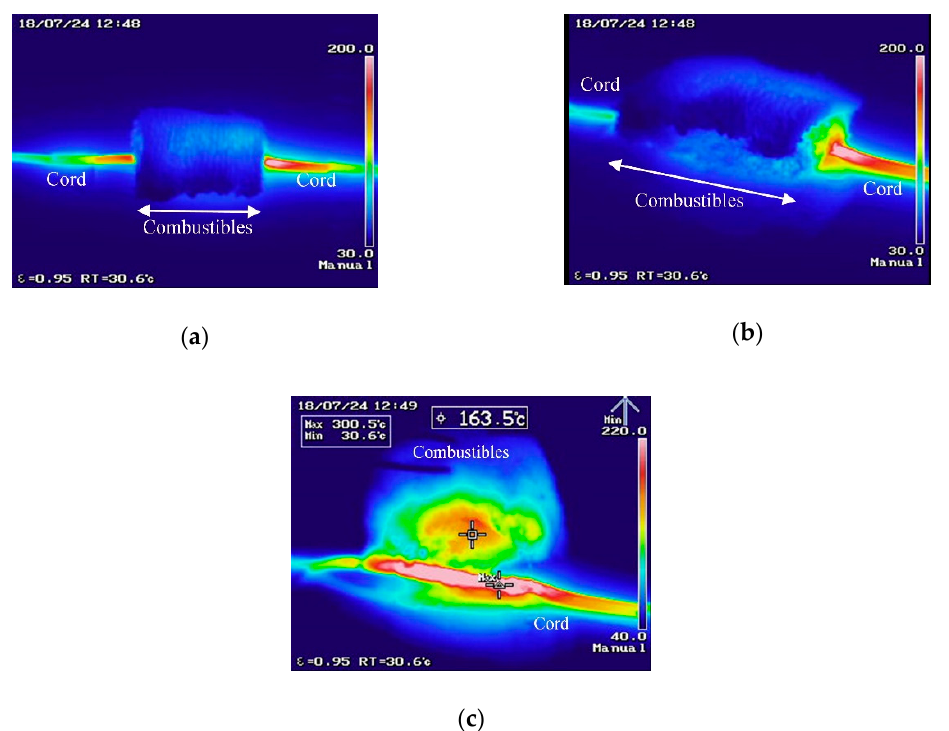
Figure 6. Temperature distribution around the partially broken part (Voltage 100 Vrms, Current 13.5 Arms). ( a ) External appearance (front view); ( b ) External appearance (oblique view); ( c ) Surface of combustibles and power supply cord (combustibles are removed and turned over).